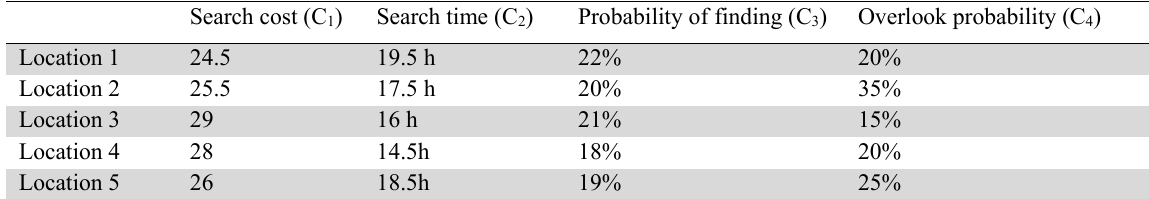
Decision matrix